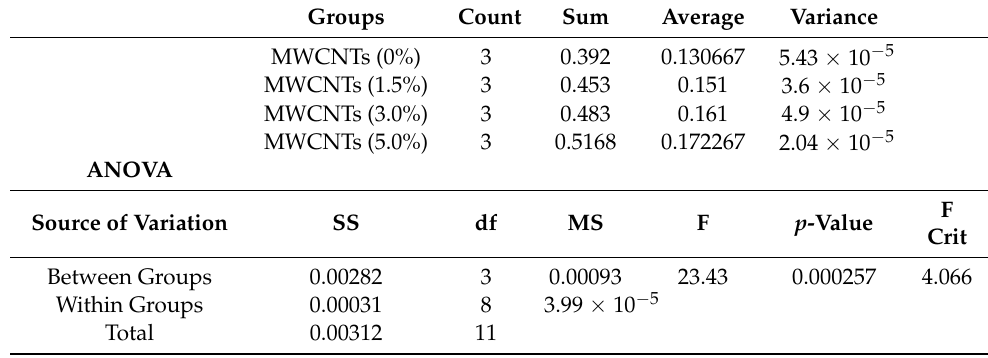
Table 8. Thermal conductivity values of MWCNTs-UF MDF for various iterations.